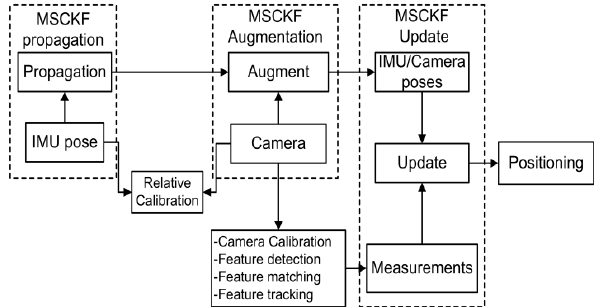
Figure 1. The general workflow of the MSCKF.